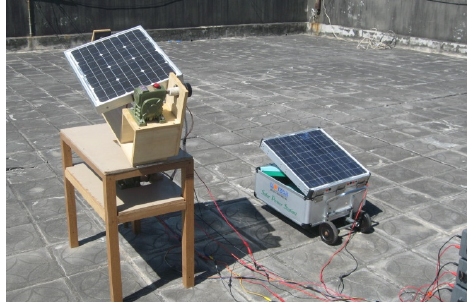
Figure 11. Hardware device of sun track system.